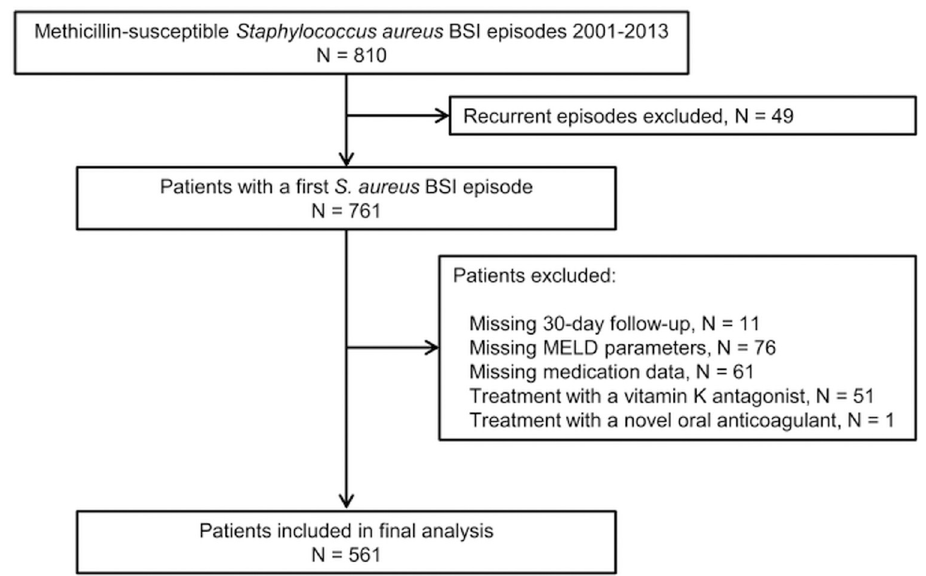
Fig 1. Selection of Patients with Staphylococcus aureus Bloodstream Infection for Final Analysis. Abbreviations: BSI, bloodstream infection; MELD, Model for End-stage Liver Disease. Sixty-one patients were excludeddue to missing medicationdata on vitamin K antagonists and novel oral